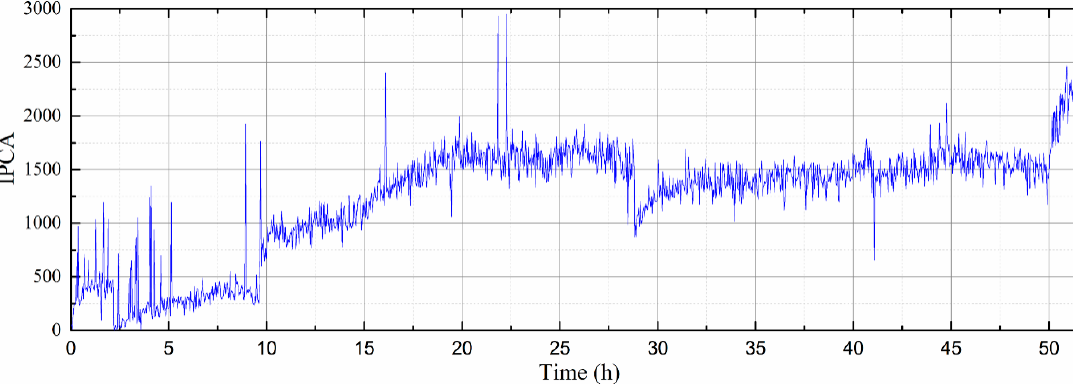
Figure 12. Variations of index of particle coverage area (IPCA) from the proposed method.